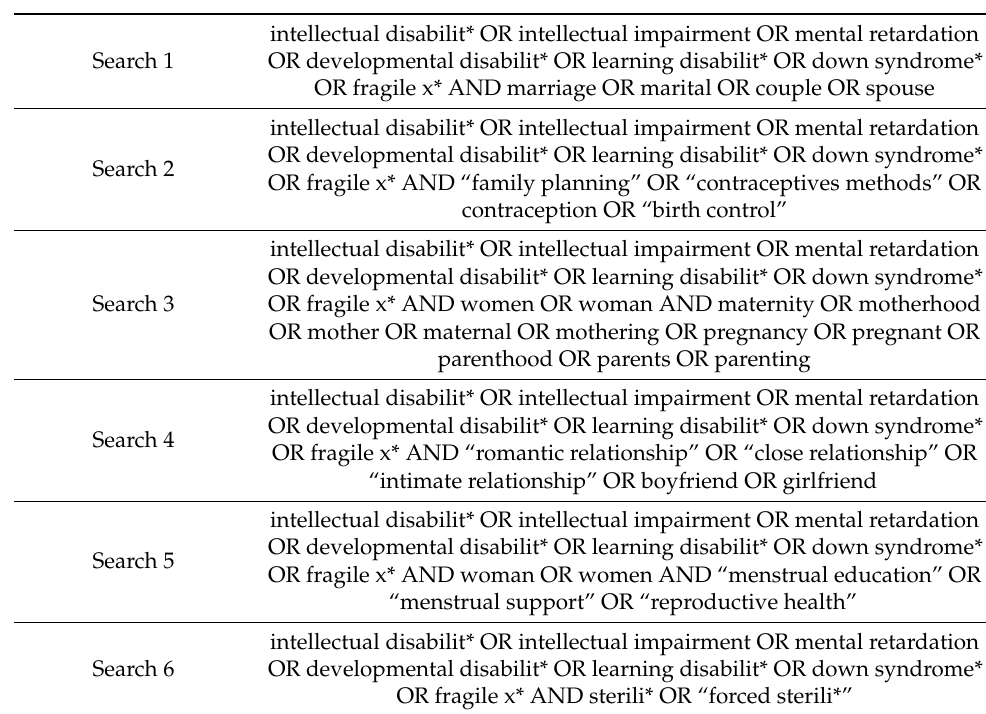
Table 1. Boolean terms used in the six searches carried out in the databases.